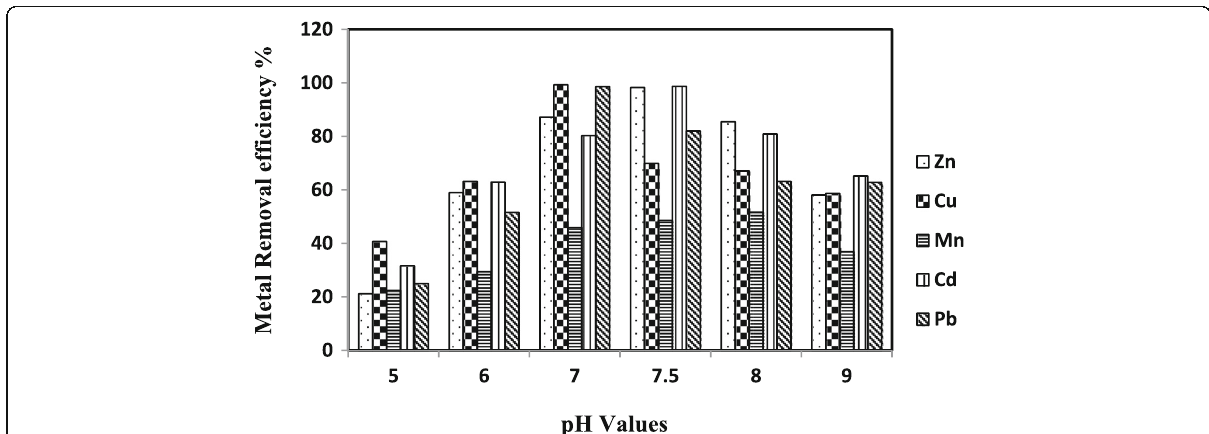
Fig. 4. A histogram showing the effect of different pH values (5 – 9) on the bio-removal of Zn 2+ , Cu 2+ , Mn 2+ , Cd 2+ , and Pb 2+ ions by using 750 mg/l of P.